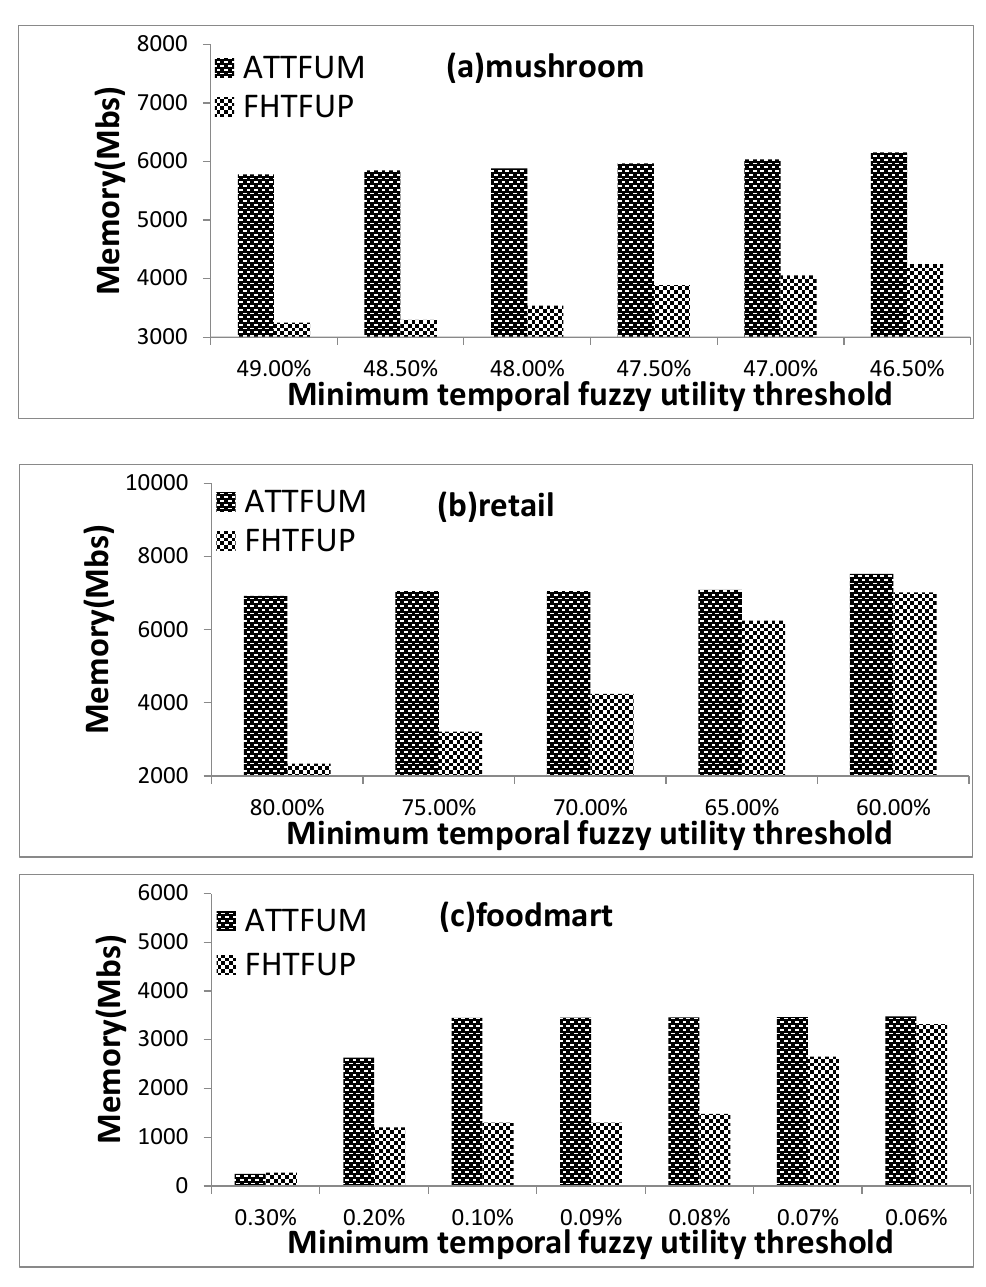
Figure 7. The comparisons of memory consumption for two methods in distinct thresholds.